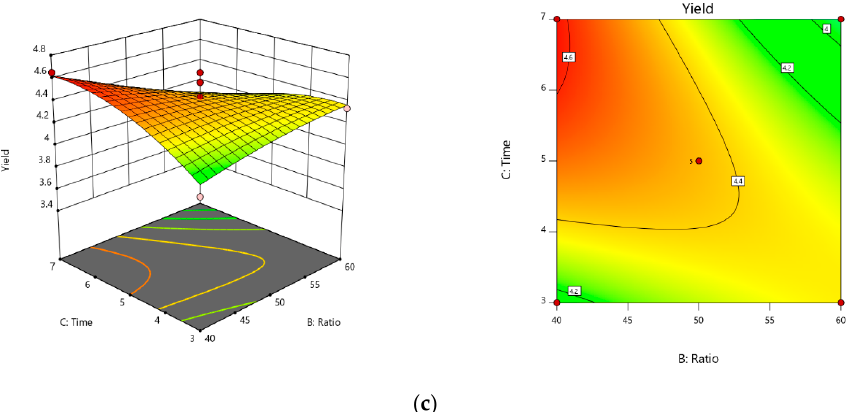
Figure 3. Response surface and contour plots for factors influencing yields of EGCG extraction include ( a ) temperature and ratio; ( b ) temperature and time; and ( c ) ratio and time.